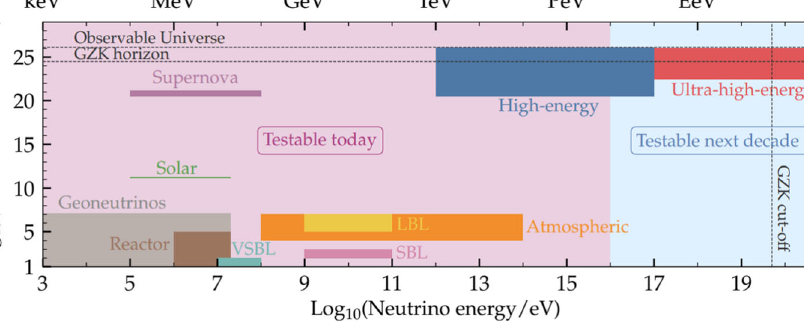
Fig. 14 Energy and distance scales relevant for neutrino telescopes. Three high-energy neutrino fluxes are labeled as atmospheric (orange), high-energy astrophysical (blue), and ultra-high-energy (red). The region explored by the current experiment is shown in pink, while next-generation is in light blue. Adapted from [697]